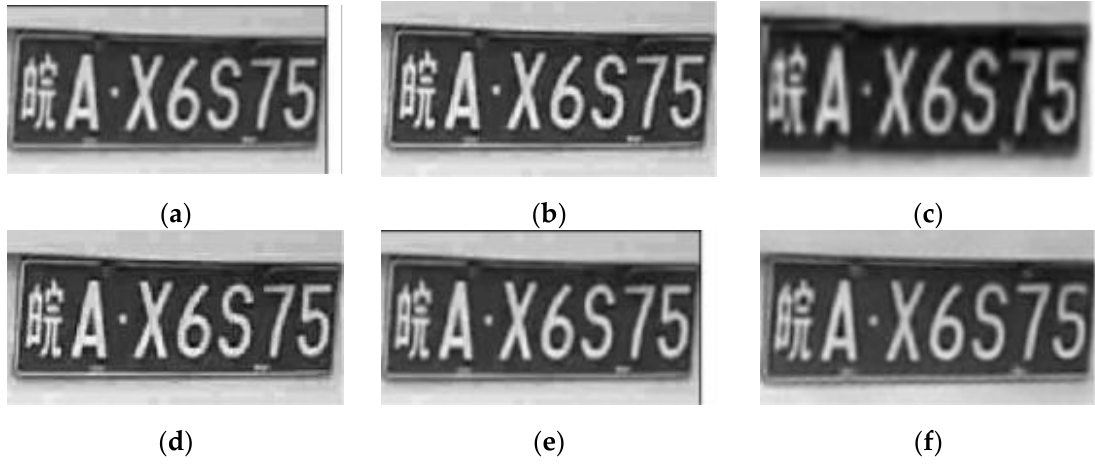
Figure 8. ( a ) Ground Truth ( b ) Bicubic; ( c ) SRCNN; ( d ) ESPCN; ( e ) SRGAN; ( f ) Our algorithm.